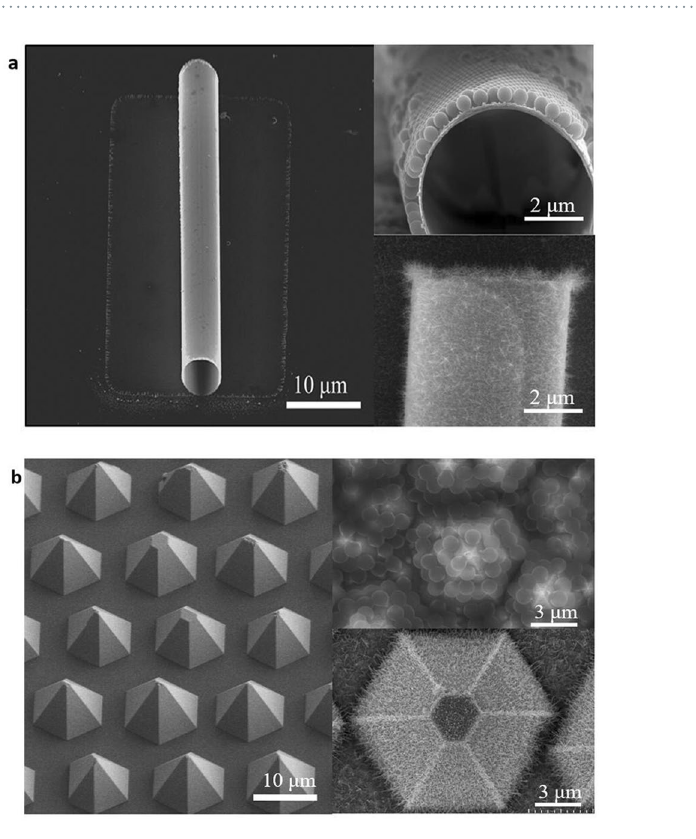
Figure 4. The SEM images and reflectance of μ -hole array. ( a ) A single micro-hole with the caliber of 10 μ m. ( b ) The cross-sectional SEM image of a micro-hole. ( c ) The patterned area on silicon. ( d ) The μ -hole array was covered by ITO nanowire networks. ( e ) The reflectance of Si with different surfaces.